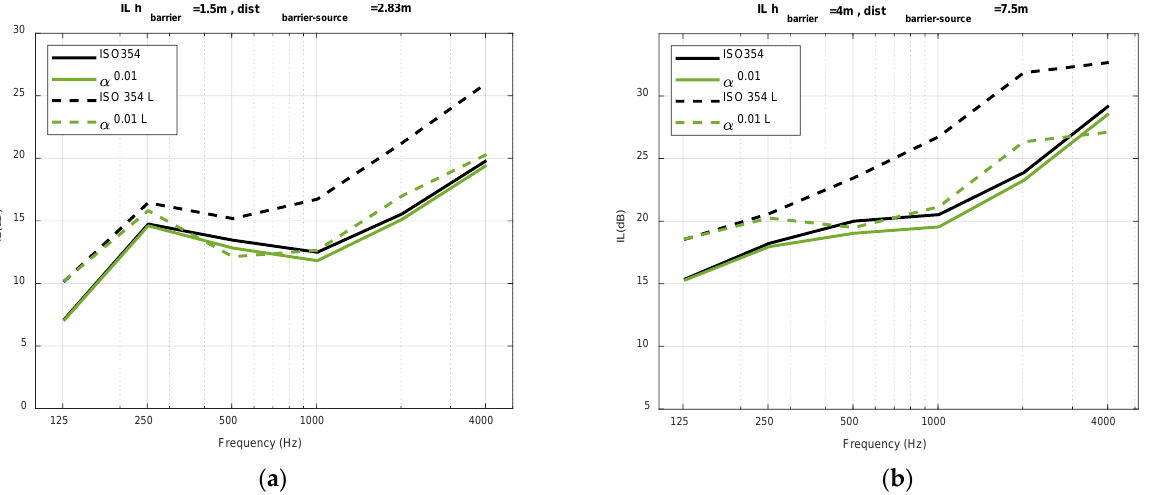
Figure 16. Insertion loss curves calculated with the BEM methodology, for reflective barriers (α 0.01 and α 0.01 L) and for barriers with an absorbing porous concrete layer (ISO 354 and ISO 354 L), with heights of: ( a ) 1.5 m and ( b ) 4 m.